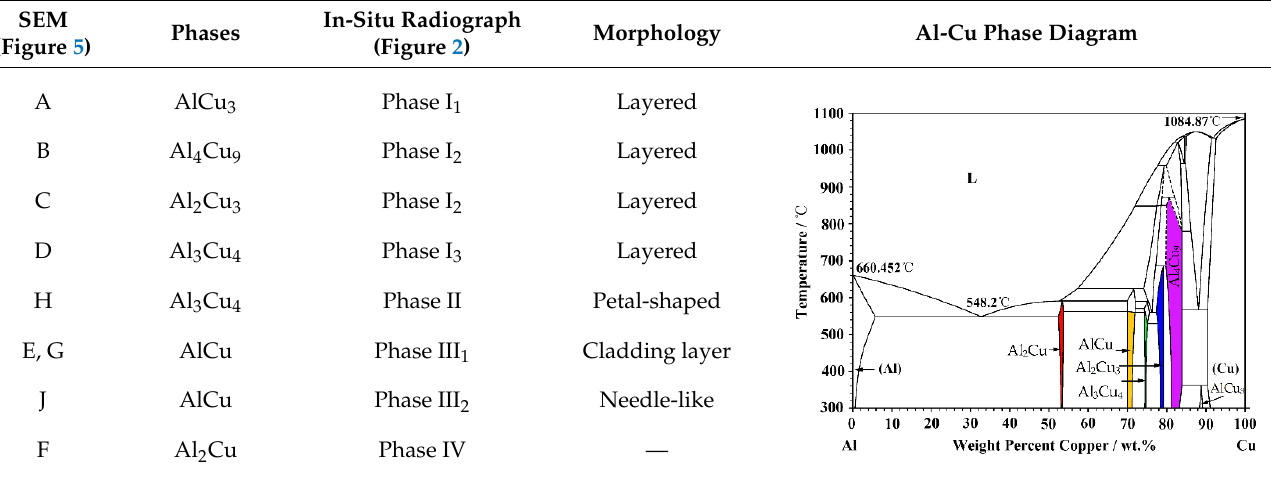
Table 1. Phases and morphology of the interfacial microstructure in Al/Cu sample.